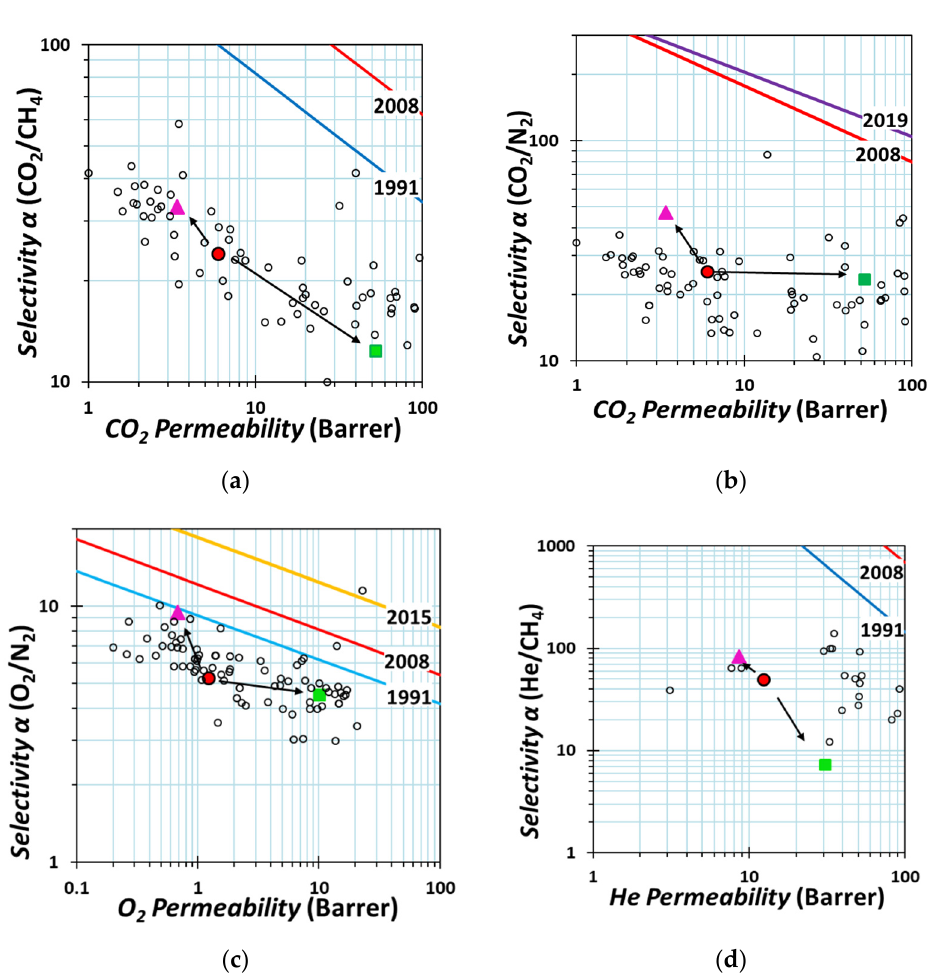
Figure 7. Robeson diagrams for the ( a ) CO 2 /CH 4 , ( b ) CO 2 /N 2 , ( c ) O 2 /N 2 , and ( d ) He/CH 4 gas pairs with the upper bounds represented by blue lines for 1991 [44], red lines for 2008 [45], yellow lines for 2015 (O 2 /N 2 ) [46], and purple lines for 2019(CO 2 /N 2 ) [47]. The gas permeability data for PEEK-WC are reported with red circles , with pink triangles for PEEK–WC/ m -xy ▲ , and with green squares for PEEK–WC/Fura ■ . Empty symbols are literature data from the database of the Membrane Society of Australasia (MSA) for Poly(aryl ethers) and Poly(aryl ether ketones)-based membranes (https://membrane-australasia.org/msa-activities/polymer-gas-separation-membrane-database/, last accessed on 29 August 2021).